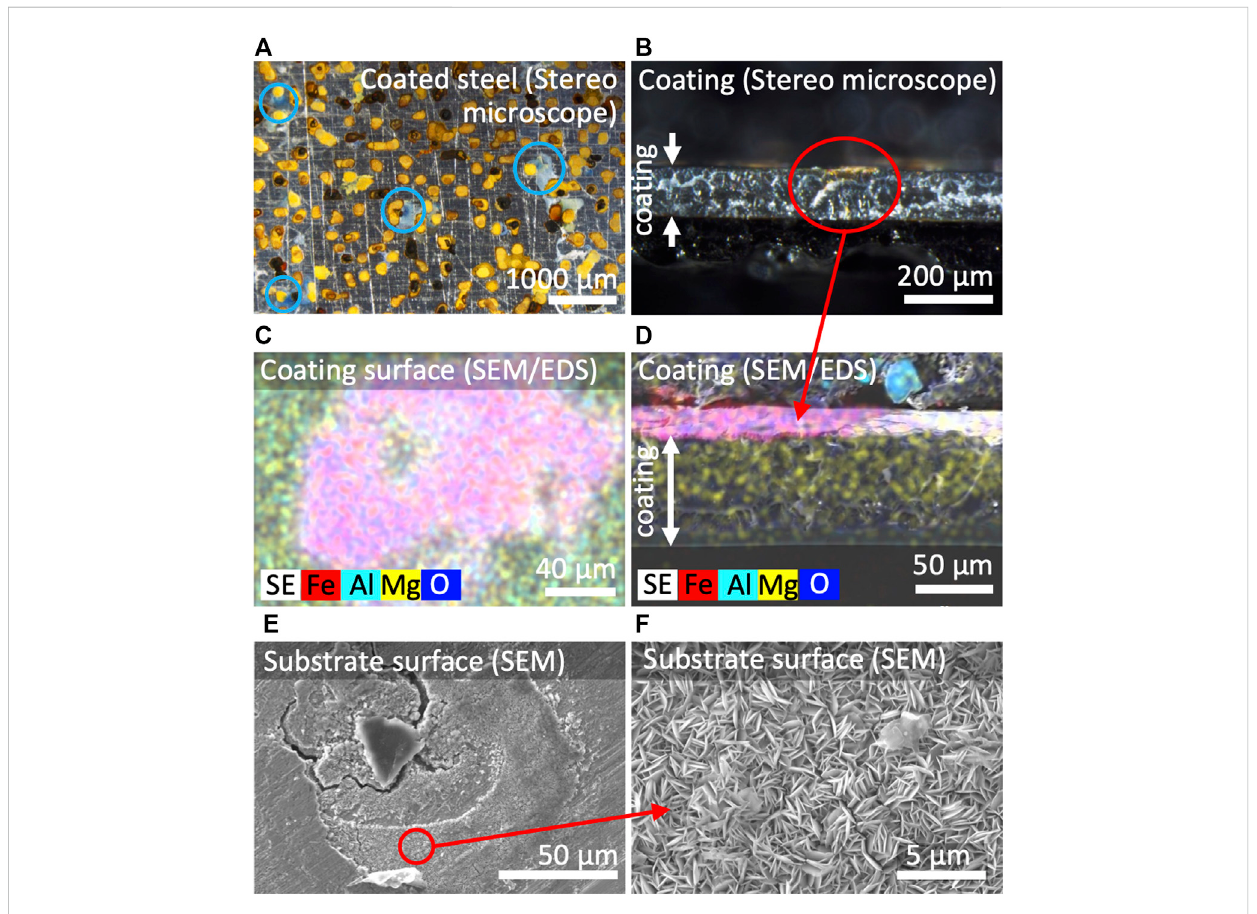
FIGURE 14 Analysis ofthesurfaceof corroded coatedwith multilayer system 2 carbonsteel plate viathestereo microscope (A) , analysisofthe cross-sectionof its separated coating (metal-coating interface side is faced to the top) via the stereo microscope (B) , SEM/EDS analysis of the surface of the separated coating from the metal-coating interface side (C) and SEM/EDS analysis of the cross-section of the separated coating (metal-coating interface side is faced to the top) (D) , and analysis of the steel substrate after removal of the coating via SEM at the magni fi cation ×800 (E) , ×6,000 (F)